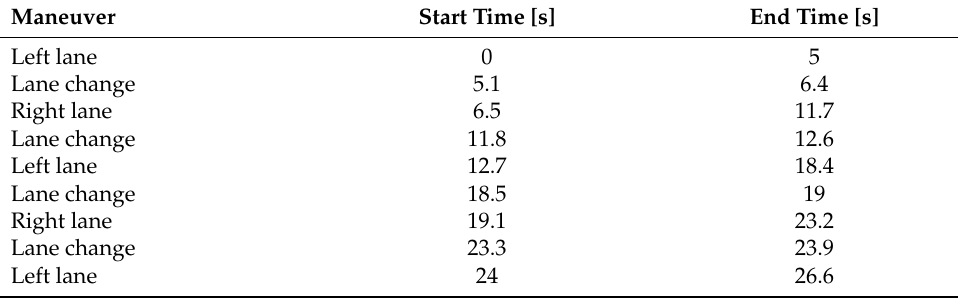
Table 1. Lateral maneuvers of the observed